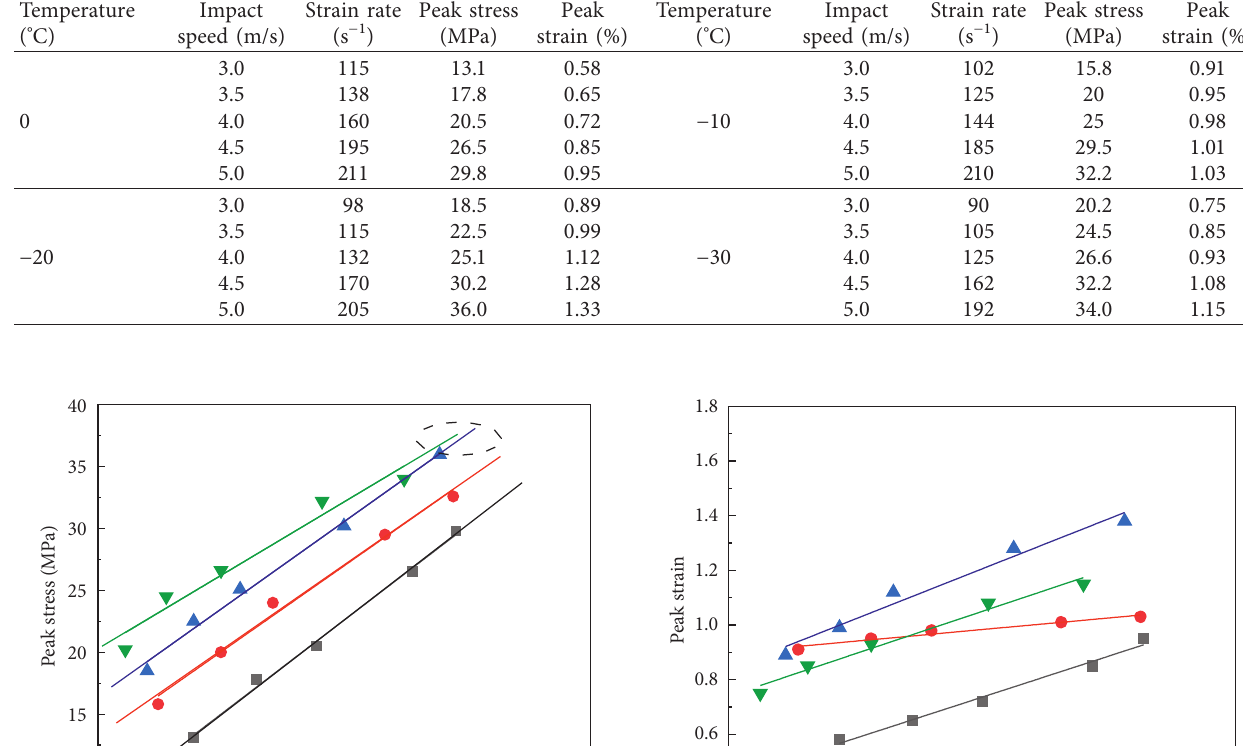
Table 2: Dynamic mechanical parameters of saturated frozen sandstone under different impact velocities.